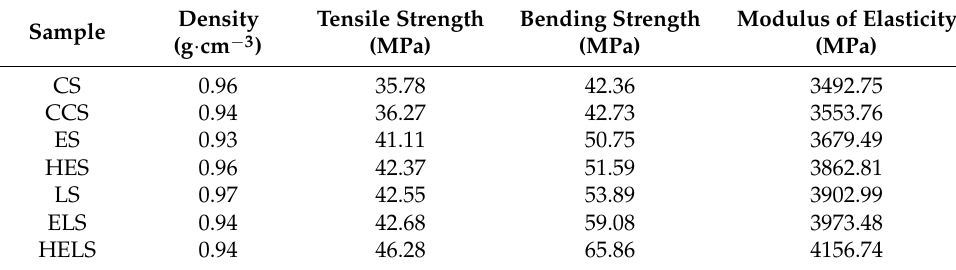
Table 7. Mechanical properties of